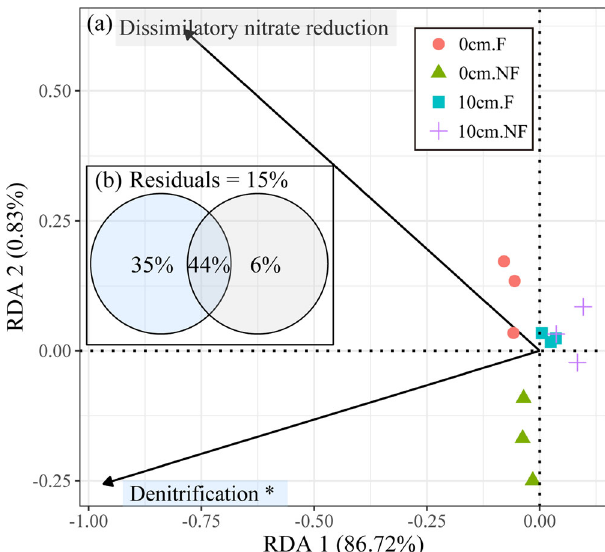
Fig. 4 The db-RDA and VPA results regarding the in fl uence of N-cycling metabolic processes on soil nitrogen. a The db-RDA result; b the VPA result; asterisk indicates the signi fi cant in fl uence of metabolic processes on soil nitrogen content; the blue shadow indicates denitri fi cation; the gray shadow indicates dissimilatory nitrate reduction; the numbers in the subplot b indicate the explained variance of different N-cycling metabolic processes on soil nitrogen; 0 cm. F: non- fl ooding × freeze-thaw; 0 cm. NF: non- fl ooding × control; 10 cm. F: fl ooding × freeze-thaw; 10 cm. NF: fl ooding ×